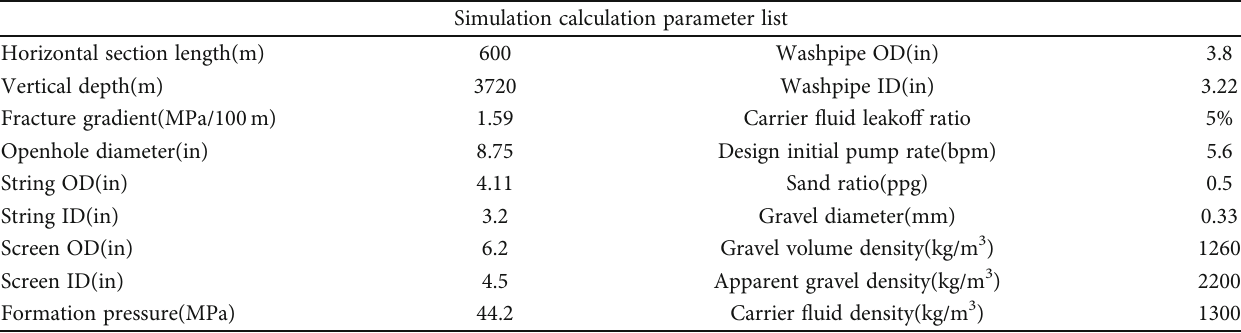
Table 1: simulation